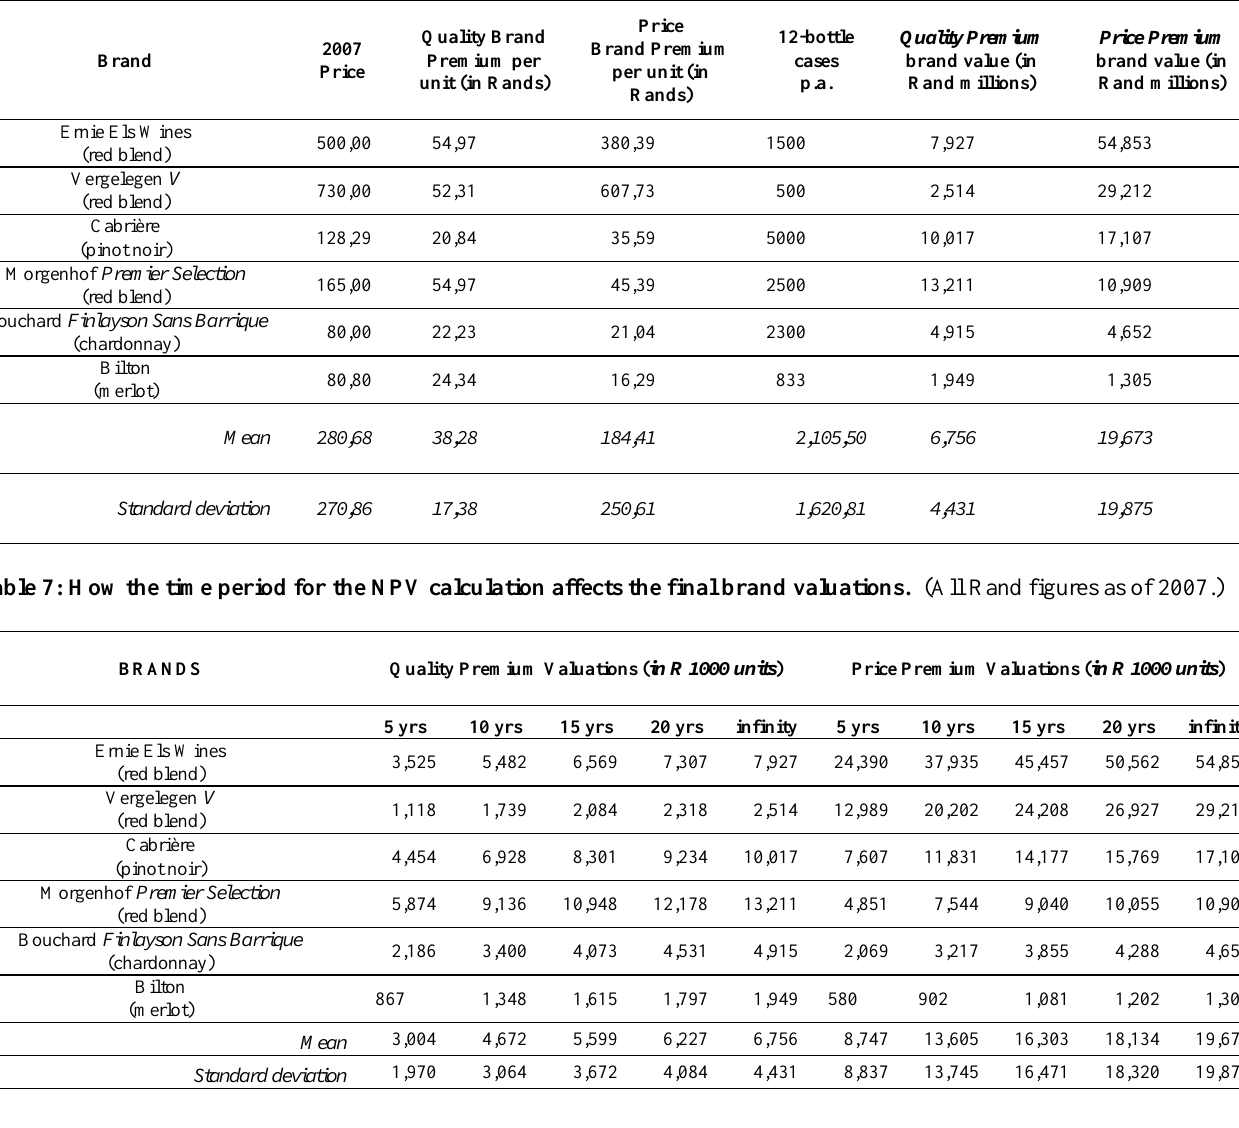
Table 6: Final brand valuations for the six brands simultaneously positive in both brand premium methodologies. These are ranked by descending order of price premium brand values (final column). (All Rand figures cited as of 2007.)